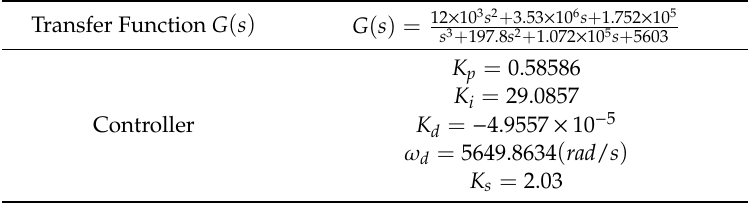
Table 4. Transfer function and controller parameters for the fuel cell-boost